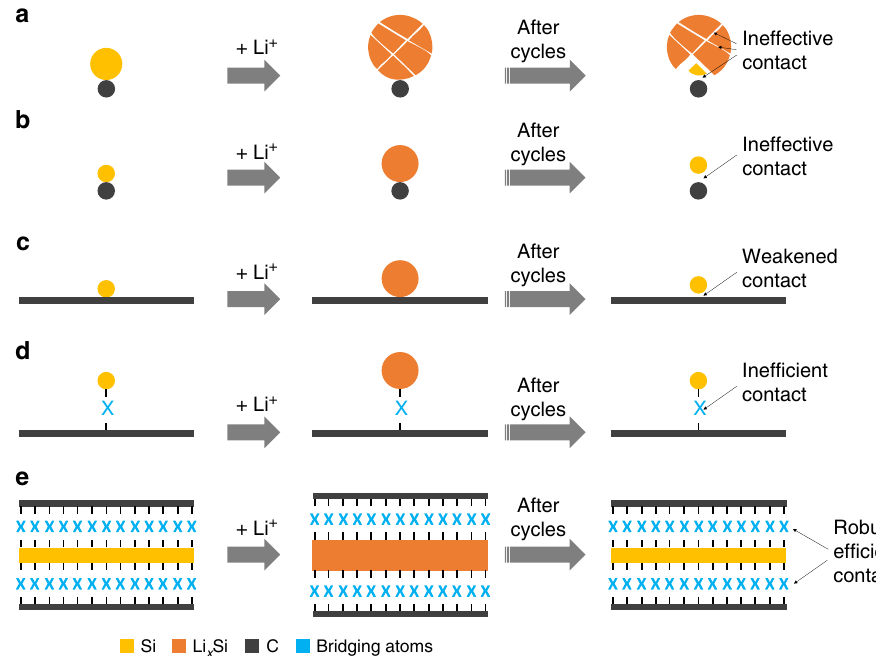
Fig. 1 Binding strategies of silicon with electrically conductive media. a Point-mode physical binding of Si with a conventional conductive medium (e.g., carbon black). The large volume change causes pulverization of Si obstructing the contact and induces side reactions, as well as SEI propagation further deteriorating the contact. The ineffective binding or unbinding of Si results in poor cycling stability. b Downsizing of Si. Although resistant to mechanical fracture, the point-mode physical contact is similarly prone to become ineffective, hindering improvement in cycling and rate capability. c Tailoring of the adjacent conductive medium. With the Si/C combination to accommodate the volume change of Si, the cycling stability is improved; yet, this is at the expense of rate capability because the easily weakened point-mode physical binding is still adopted in most cases. d Manipulation of the binding between Si and the adjacent conductive medium. As the point mode of covalent binding is inef fi cient and unfavorable for the rate capability, the existing covalent binding still encounters risks of being disrupted due to the direct contact and propagating erosion of Si with the electrolyte. e Designing two-dimensional covalent binding for Si. This skin-like binding creates and more importantly, secures a robust and ef fi cient contact between Si and C components, granting stable and fast electron/ion transport from/to the Si upon cycling. It is noteworthy that Li + is de fi ned as lithium